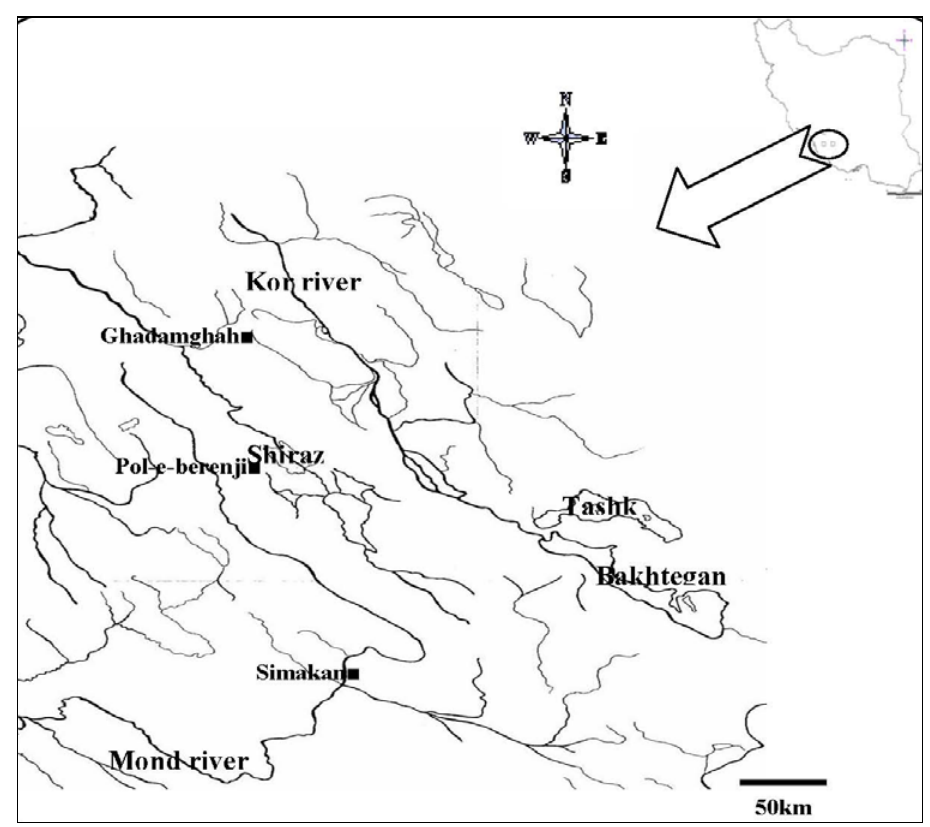
F IG .1. – Map of Iran and Fars showing position of Ghadamgah spring-stream system in Fars